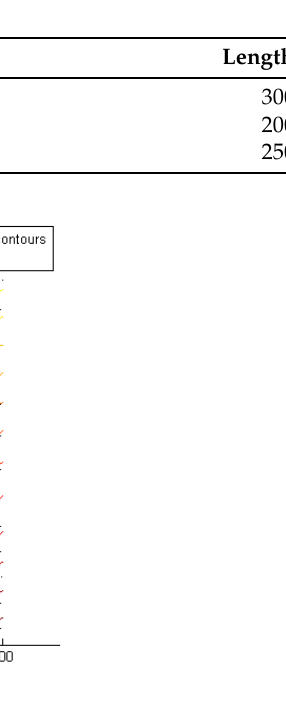
Figure 10. 3 fractures with same hydraulic conductivities but different apertures and lengths in a uniform flow field with prescribed parameters of Table